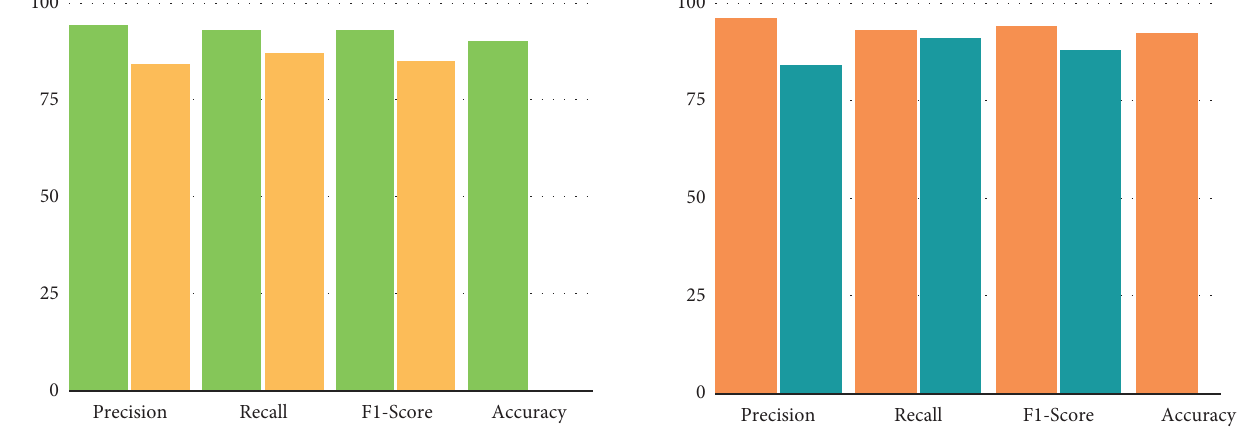
Figure 17: Random forest graph. Figure 18: Light gradient boosting machine